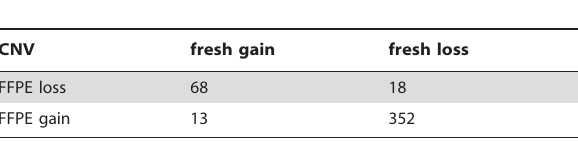
Table 3. Correlation of CNV callings between FFPE and matched fresh frozen tissues by segment